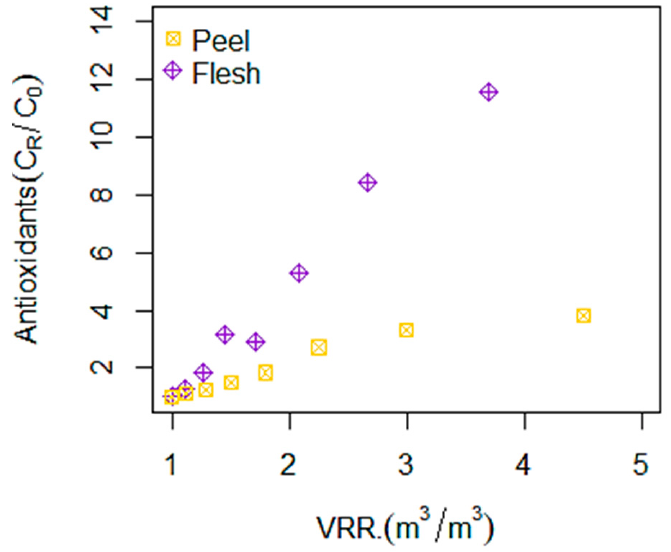
Figure 3. Variation of antioxidant capacity with VRR during concentration by RO membrane (X20). Flux behaviors for filtration of beetroot peel and flesh extracts by RO membrane with different VRRs are shown in Figure 4. In both cases, permeate flux was reduced with the increase of VRR. Reduction of permeate flux was more for flesh extract compared to peel extract. VRR reached 1.5, 2, 2.5, and 3 at 7.4, 11.6, 14.3, and 15.8 min of filtration time, respectively, in the case of flesh extract. On the other hand, VRR reached 1.5, 2, 2.5, and 3 at 6.5, 9.7, 11.9, and 13.4 min of filtration time, respectively, in the case of peel extract.